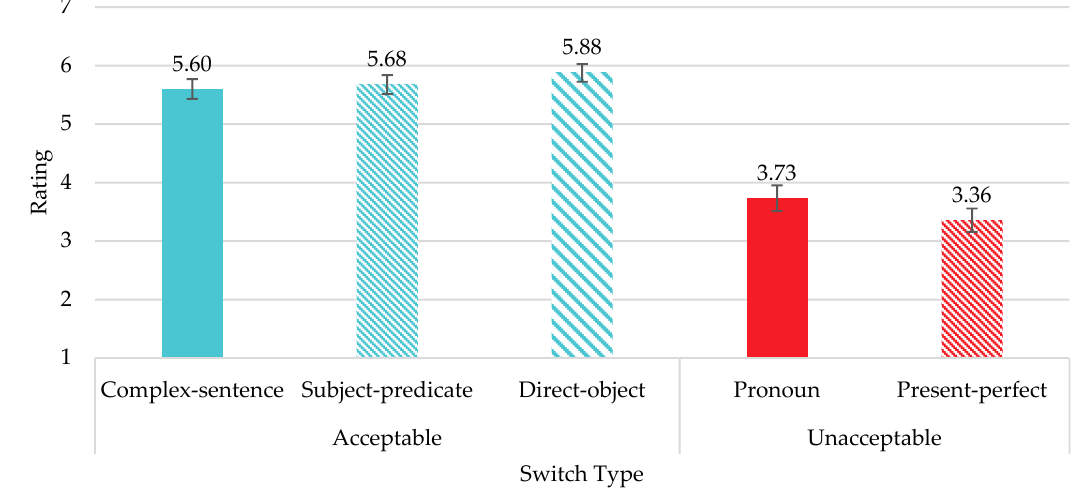
Figure 1. Mean rating of control stimuli by switch type.